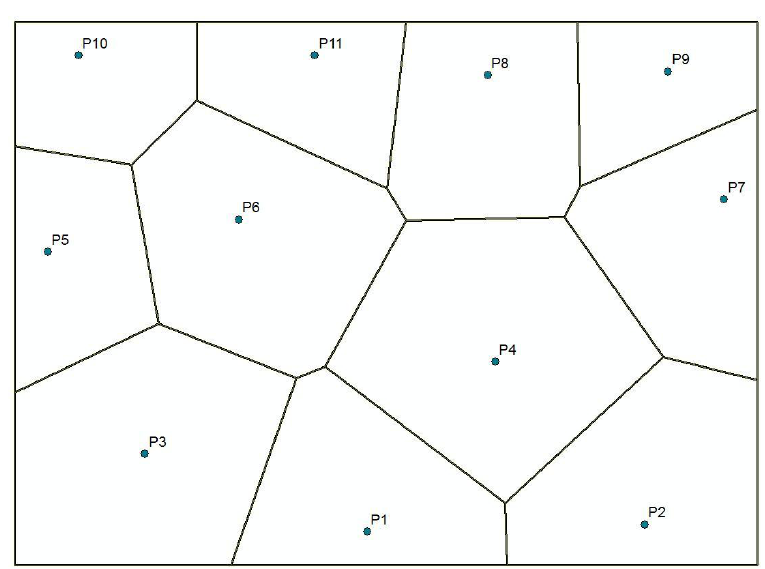
Figure 3. An example of Voronoi diagram.